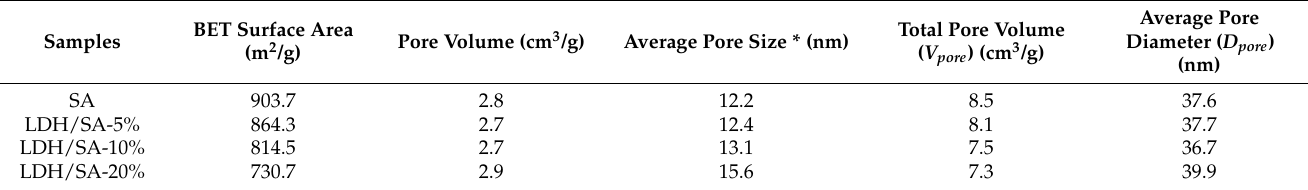
Table 1. Physical properties of SA and LDH/SA composites.